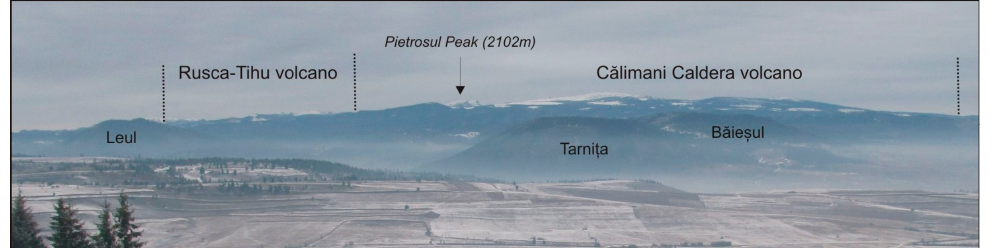
Figure 7. Panoramic view of the C ă limani Mountains, as seen from the South (Topli ț a ski resort area) across the Mure ş valley. The topographic features labeled Leul, Tarni ț a, and B ă ie ș ul are pe- ripheral domes of the C ă limani Mountains (Photo: Alexandru Szakács).